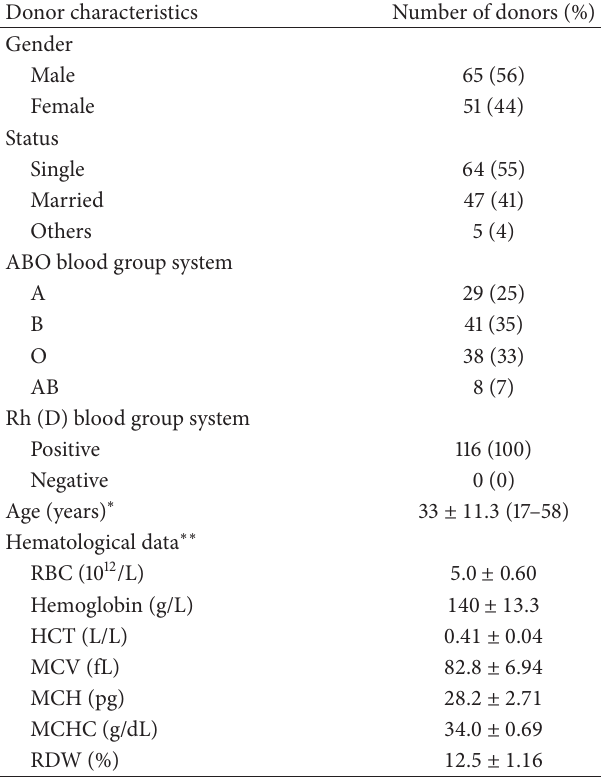
Table 1: Descriptive data and hematological findings of voluntary blood donors (𝑛 = 116) .